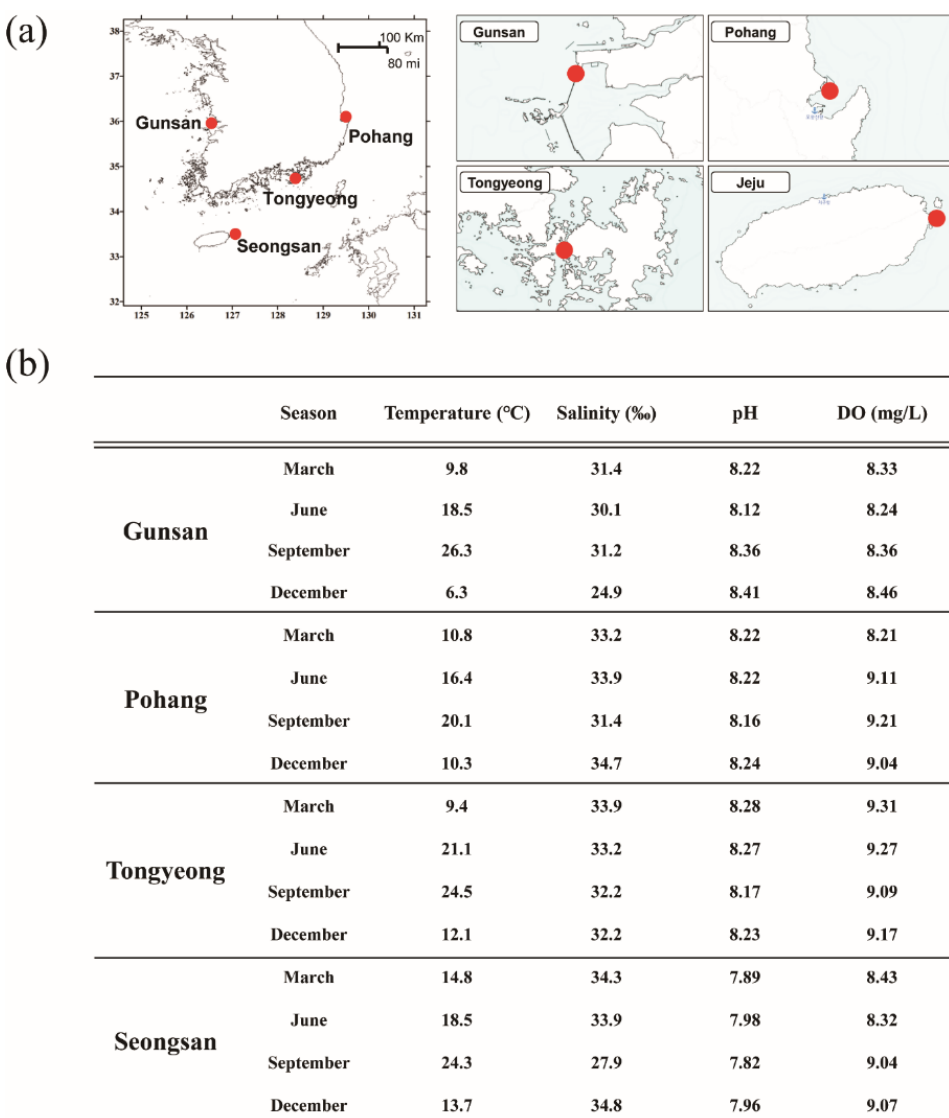
Figure 1. Location of sample sites and environmental indices at these sites ( a ) in four regions of Korean coastal waters ( b ).